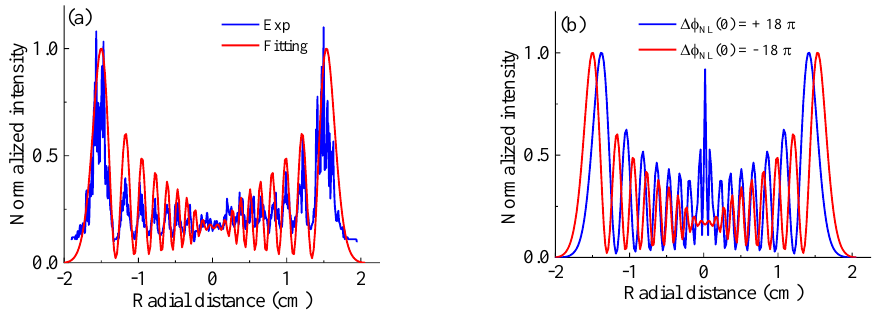
Figure 4. ( a ) Two-dimensional diffraction profile as a function of radial distance using a maximum nonlinear phase shift ∆ φ NL ( 0 ) = − 18 π . ( b ) Demonstration of diffraction patterns for positive and negative maximum nonlinear phase shift of 18 π .